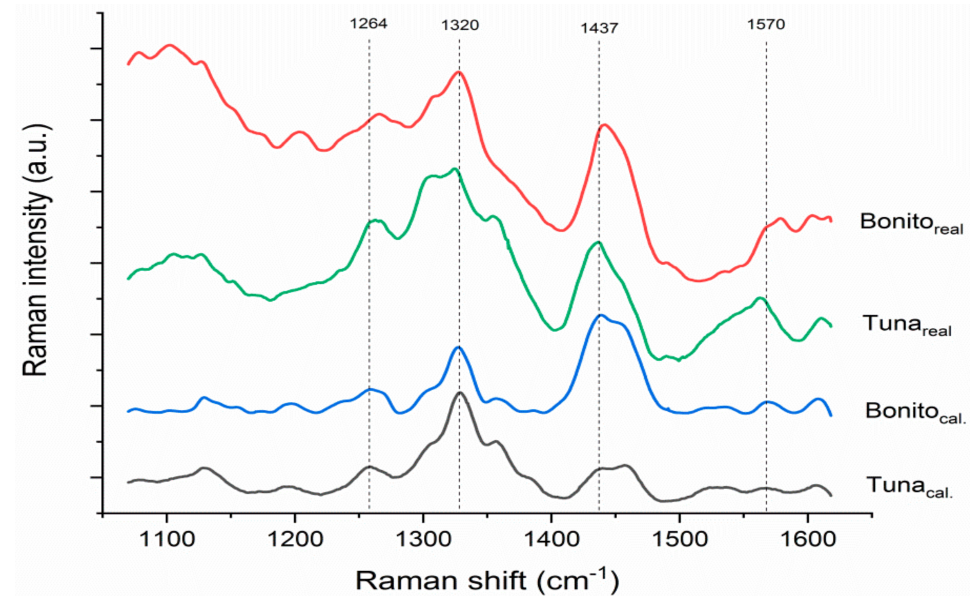
Figure 1. SERS spectra of calibration samples spiked with 75 mg/kg histamine and real samples T5 and B3 with similar histamine